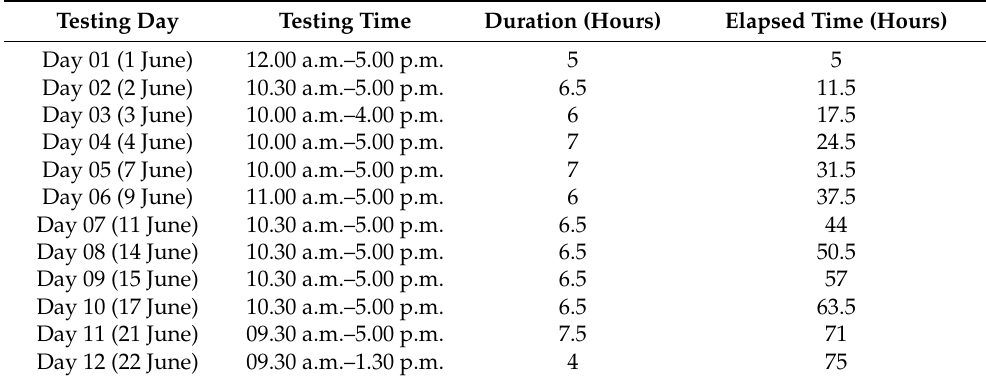
Table 1. Endurance test schedule (wind speed: 6 m/s). Testing Day Testing Time Duration